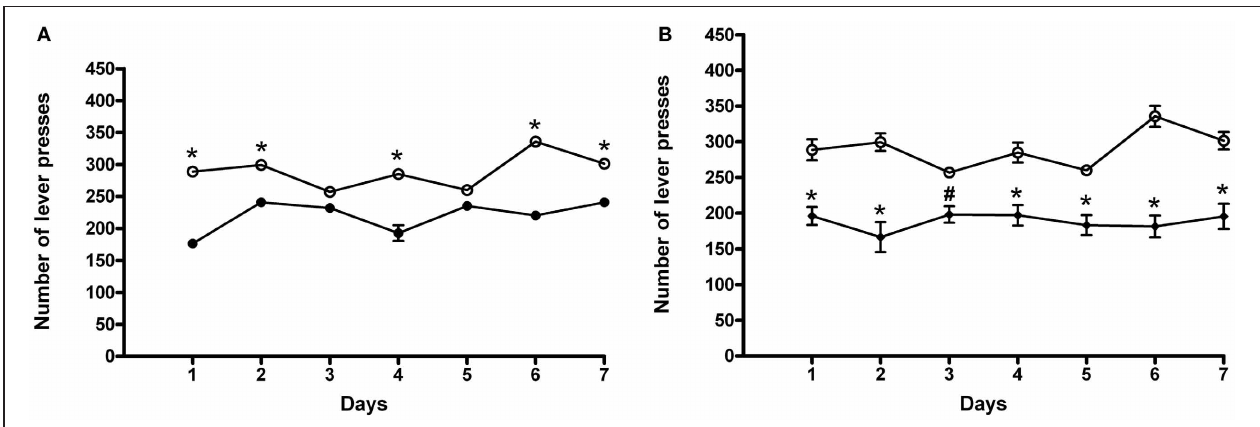
FIGURE 3 | Effects of ACD (A) and AM281 treatment (B) on the number of lever presses during the relapse periods. Each value represents the means ± S.D. of 16 rats. # p < 0 . 05; ∗ p < 0 . 001 vs. respective controls. ( ) CTR, ( ) ACD, ( ) (ACD-AM281).